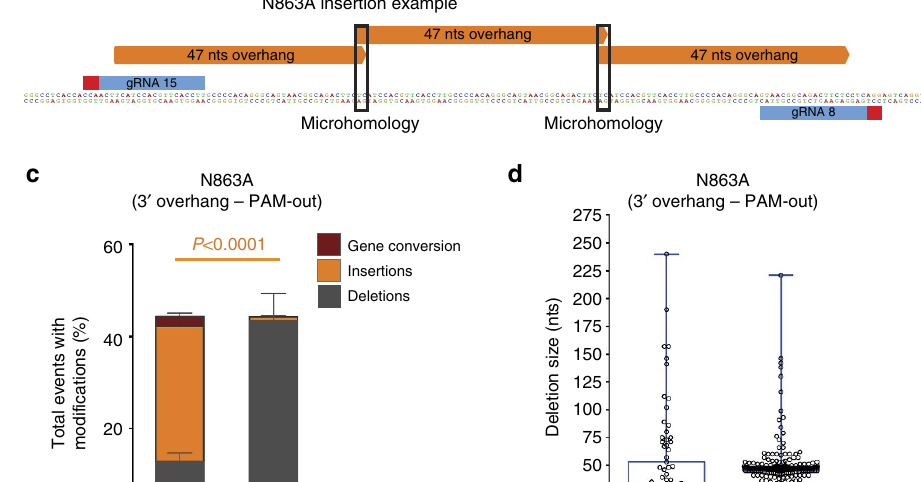
detected no precise deletions for the PAM-in configuration.